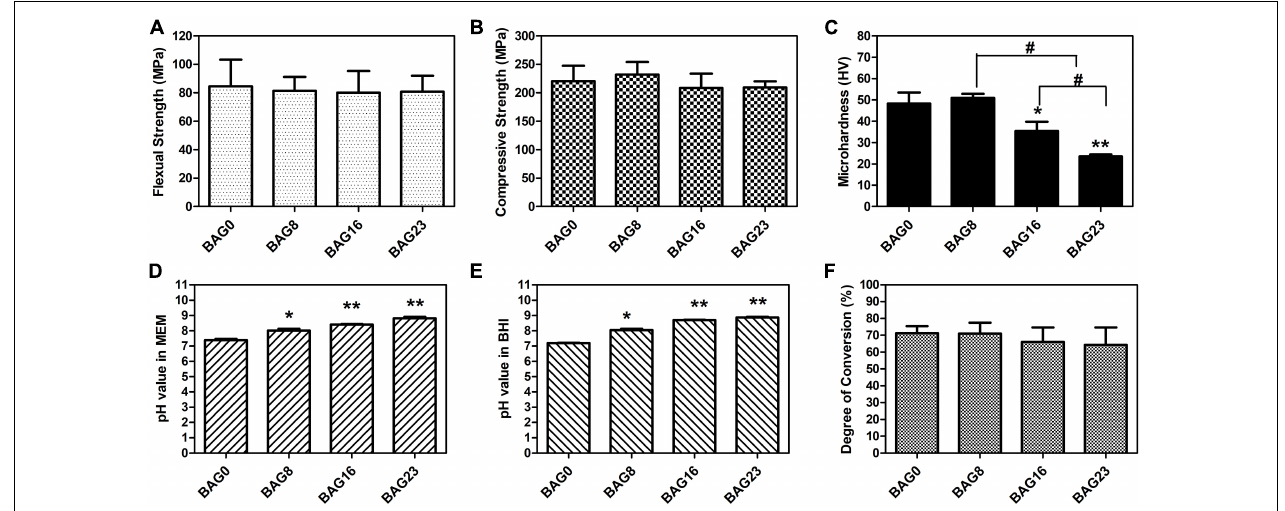
FIGURE 2 | Physicochemical and mechanical properties of bioactive glass (BAG)-modified composite resins. (A) Flexural strength. (B) Compressive strength. (C) Microhardness. The changes in pH values in the extracts of various BAG-modified composite for 24 h in MEM (D) and in BHI (E) . (F) Degree of conversion. MEM: the extracts of various BAG-modified composite resin in MEM with 10% FBS; BHI: the extracts of various BAG-modified composite resin in brain heart infusion (BHI). All the data represent the mean ± SD ( n = 5); * p < 0.05, ** p < 0.01 vs. the BAG0 group; # p < 0.05 significant difference as compared